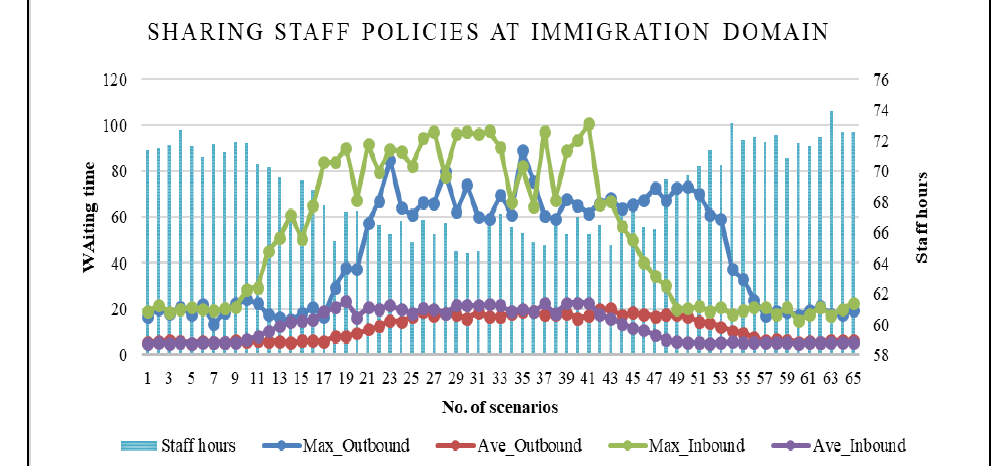
Figure 9. Influence of the dynamic resource allocation method on boarding procedures.